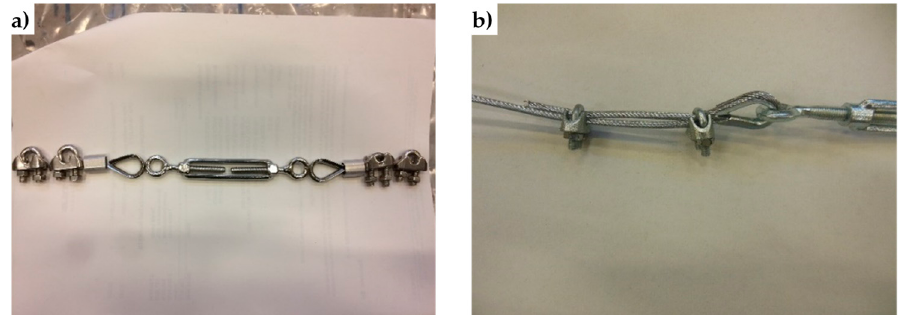
Figure 53. Devices used to fasten the loose ends of the steel wire ropes together, in the second combined technique: ( a ) overview of the sequence of devices, consisting of an eye-eye turnbuckle in the middle and a series of two clips, one ferrule, and one thimble on both sides. ( b ) How to install the clips, with the saddle portion of the clamp assembly placed against the “live” end.